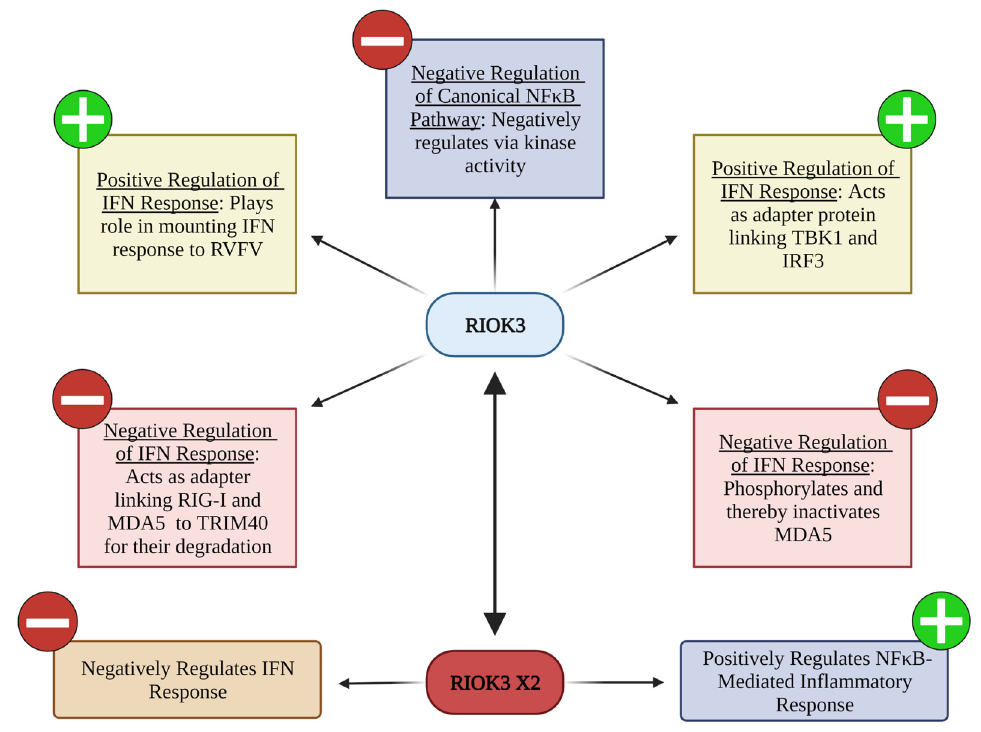
Figure 6. Current knowledge of RIOK3 ′ s modulation of innate immunity to RNA virus infection.